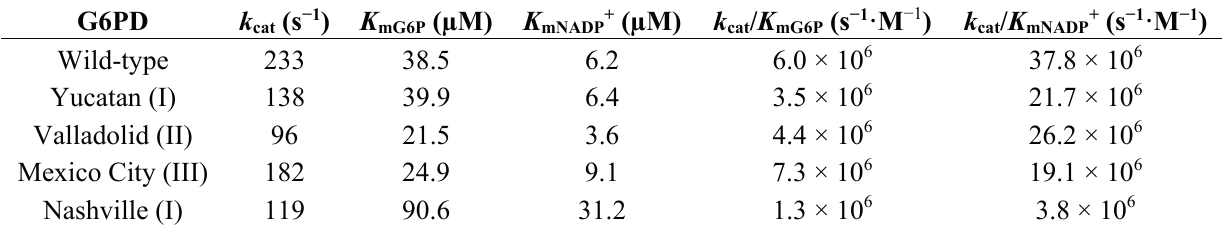
Table 2. Steady-state kinetic parameters of human recombinant G6PD